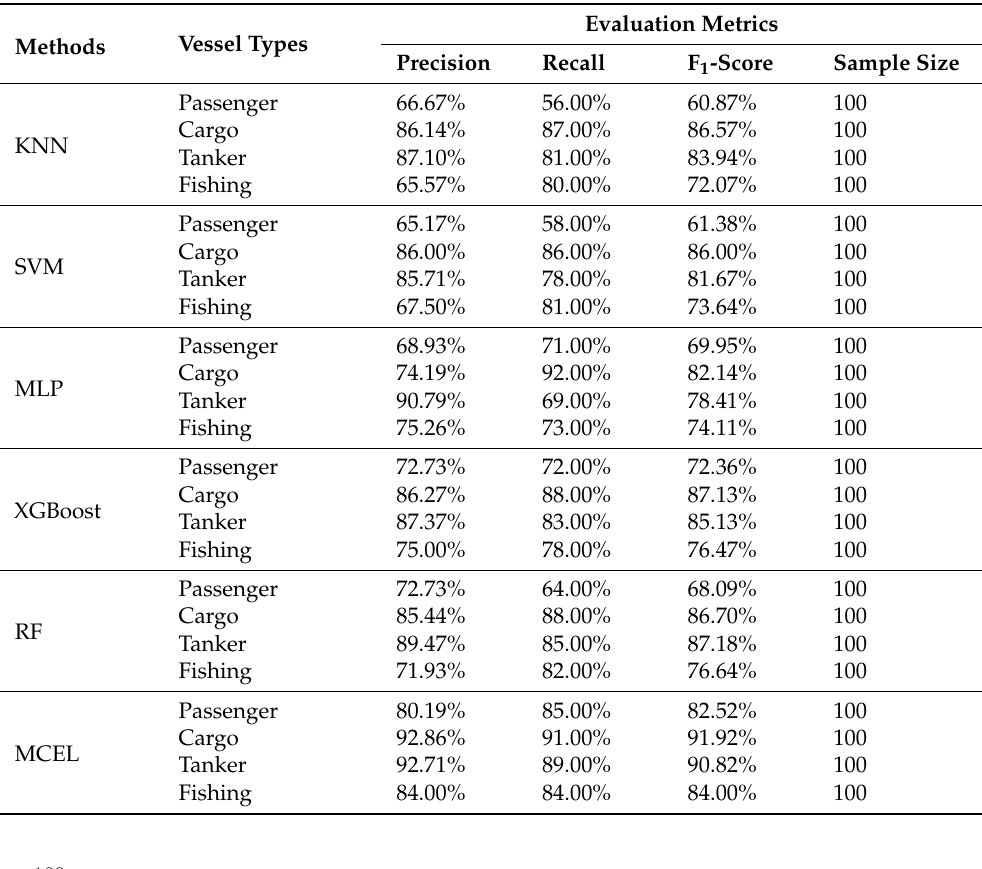
Table 3. The detailed experimental results of different classification methods on the AIS test set using the NGFs.